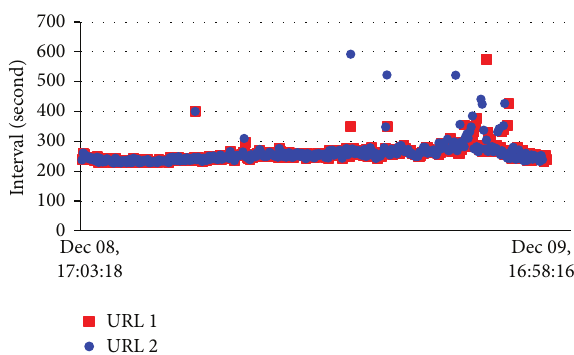
Figure 5: Access graphs from an autoware of a client IP to two